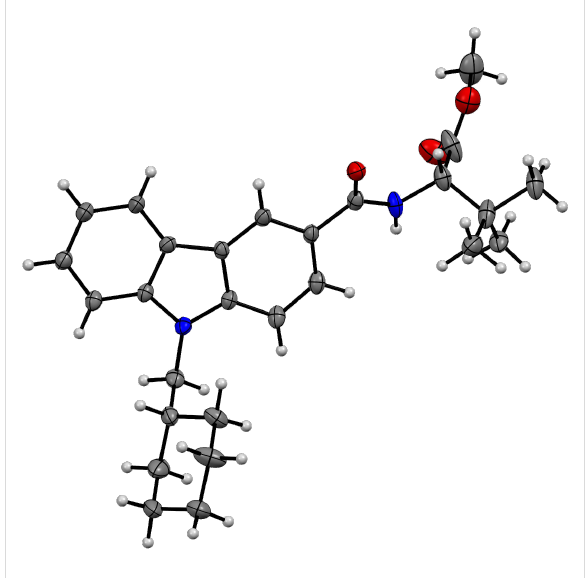
Figure 6: Molecular structure of ( S )- 3 in the solid state at 110 K (ORTEP-ellipsoids drawn at 30% probability, C black, H gray, N blue, O